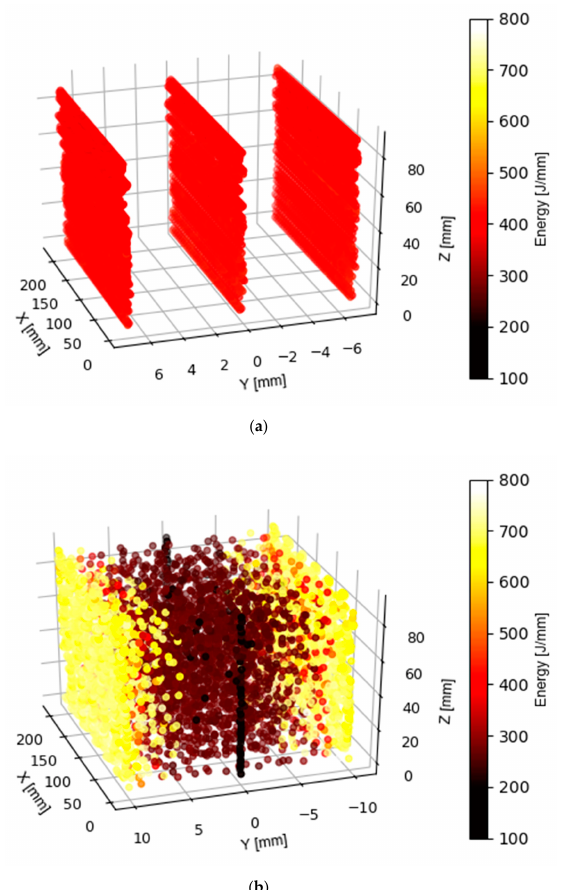
Figure 9. Deposition Energy during wall manufactured under ( a ) overlapping strategy and ( b ) oscillating strategy. In order to ensure that the motion system has completed what was programmed in the manufacturing of the oscillated wall, Figure 10 presents the generated bead in the first layer. The width of the bead is slightly less than 20 mm of the target wall, because in layer 0 the substrate is cold and there is greater growth in the Z direction and a slight decrease in width. The marks appreciated in Figure 10 are generated due to the oscillatory path and, by measuring the distance between two consecutive marks, the actual wavelength of the process can be determined.